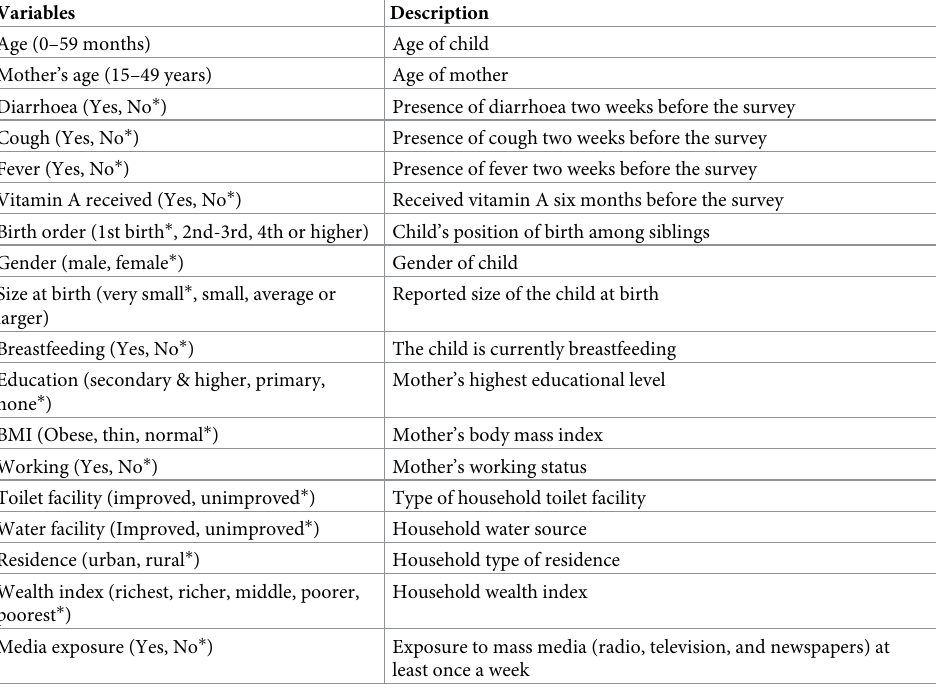
Table 2. The description of all the variables in the 2018 NDHS